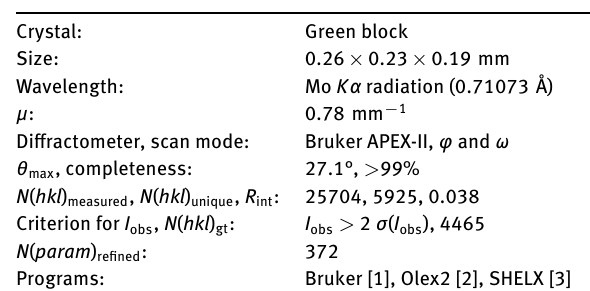
Table 1: Data collection and handling.